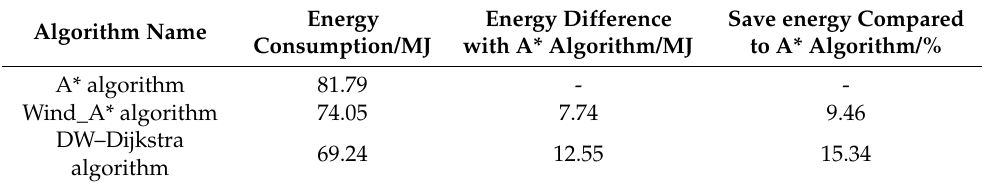
Table 3. Comparison of energy consumption of three algorithms in a real wind